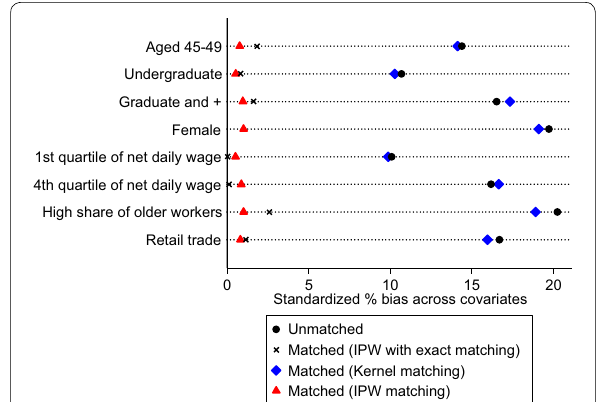
Fig. 3 Standardized differences in means of covariates between individuals employed in changing firms and those employed in non‑changing without and with different matching techniques. Source: COI survey 2006/INSEE‑DARES‑CEE. Coverage: Workers aged 45–57 years old with at least 1 year of seniority and employed in firms with 20 workers or more. Note: Treated individuals are work‑ ers employed in changing firms, i.e. firms that have experienced substantial ICT and management changes. We plot standardized biases without matching (black circles) and with different matching techniques (black crosses for IPW with exact matching by gender, blue diamonds for Kernel matching and red triangles for IPW match‑ ing). We report only covariates for which standardized bias without